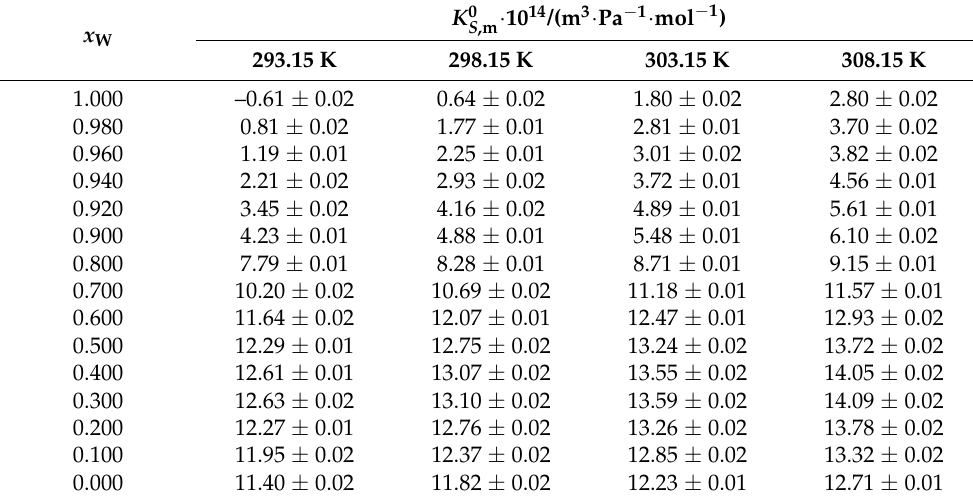
The uncertainty of the mole fraction x W is equal to ± 1 · 10 − 3 . Table 7. Standard partial molar compression of hexaglyme in the DMF + W mixed